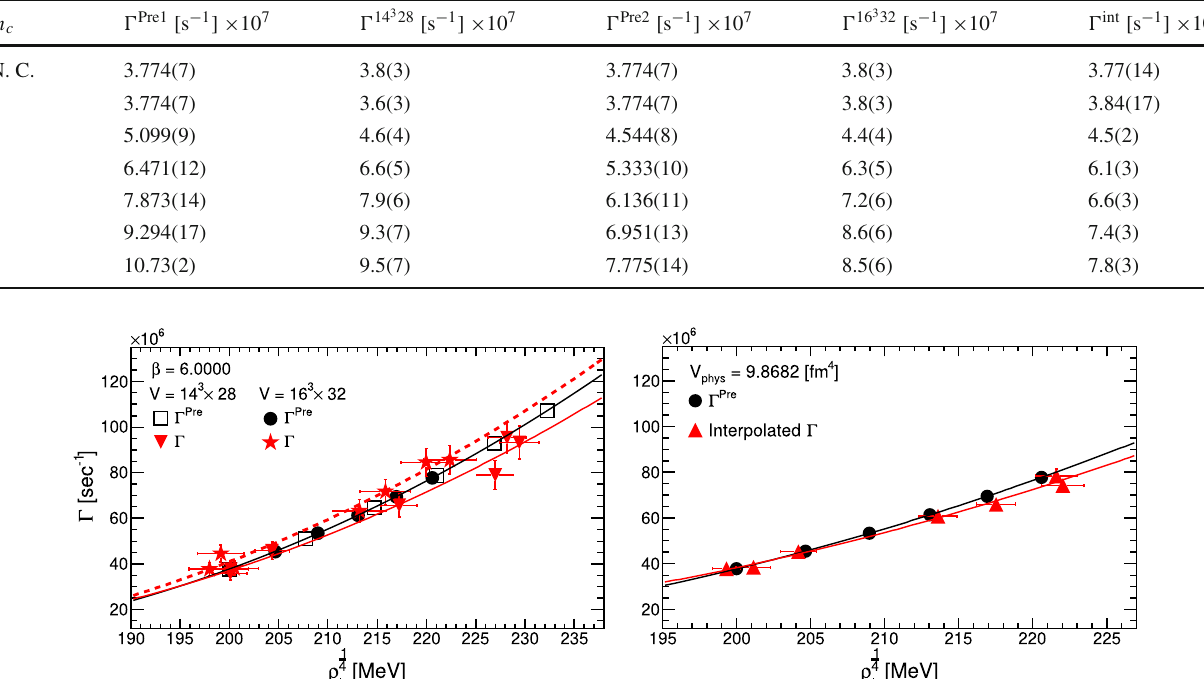
Fig. 20 Comparing the partial decay width of the charged pion (cid:15) of the configurations β = 6 . 0000, V = 14 3 × 28 and V = 16 3 × 32 (left) and the interpolated results (right) with the predictions (cid:15) Pre . In the left figure, the black full line, the red full line, and the red dashed